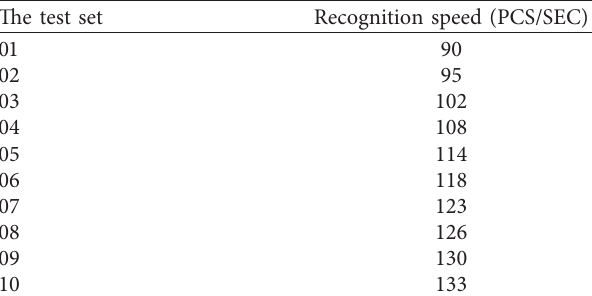
Table 6: Recognition speed of Method 2.